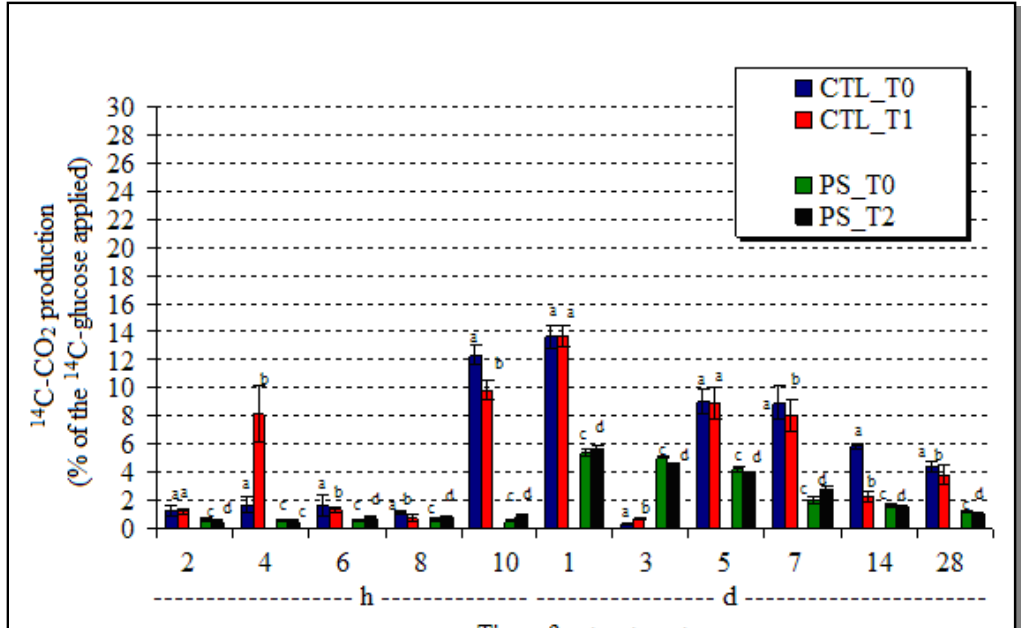
Figure 4. Substrate ( 14 C-glucose)-induced respiration of the soil AVEC treated either with chlorothalonil (CTL_T1) or the P. sonchifolia methanol fraction (PS_T2) and their respective controls (CTL_T0; PS_T0), during 28-day incubation. (h = hours; d = days; mean ± SD; different letters near the bars indicate statistical difference in relation to the